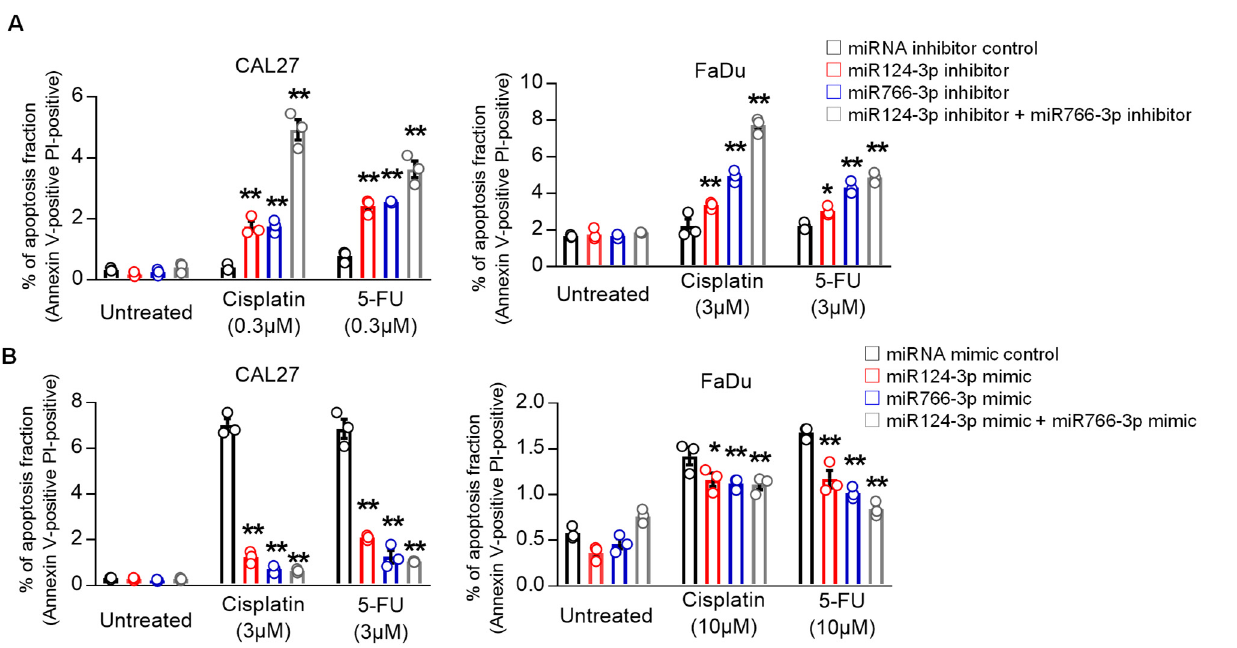
Table S6. Two-sided unpaired Student t test was used to analyze comparisons, and one-way ANOVA with Bonferroni’s correction for multiple comparisons was used to analyze group comparisons. Data are presented as means ± SD (n = 3). Each experiment was performed three times, and each time it included triplicate samples. * p < 0.05, ** p < 0.01 and *** p < 0.001.